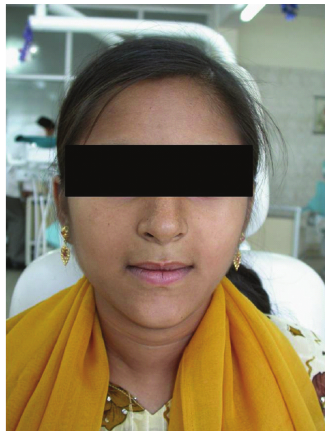
Figure 2: Facial appearance of